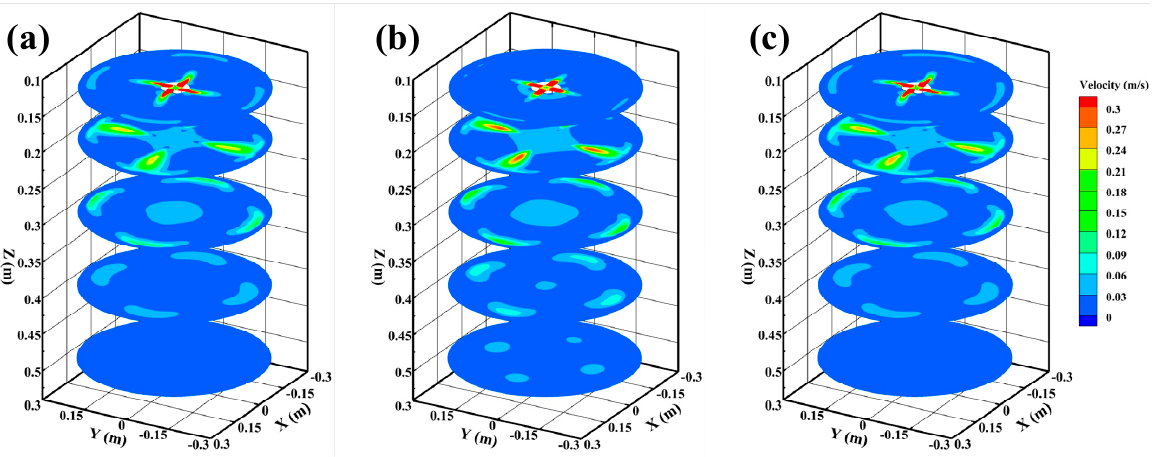
Figure 7. Velocity distributions in cross section of strand without M-EMS ( a ) –15° SFN, ( b ) 0° SEN, and ( c ) +15° SFN.